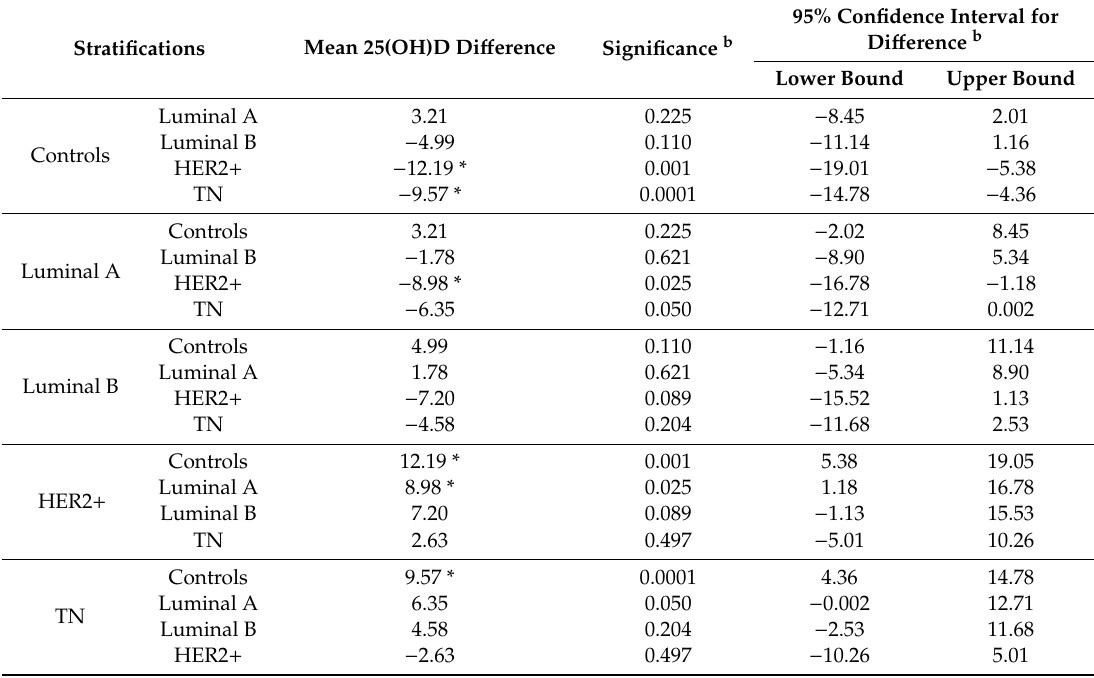
Table 6. Di ff erences in mean 25(OH)D levels among women with BC with low DRC with di ff erent molecular